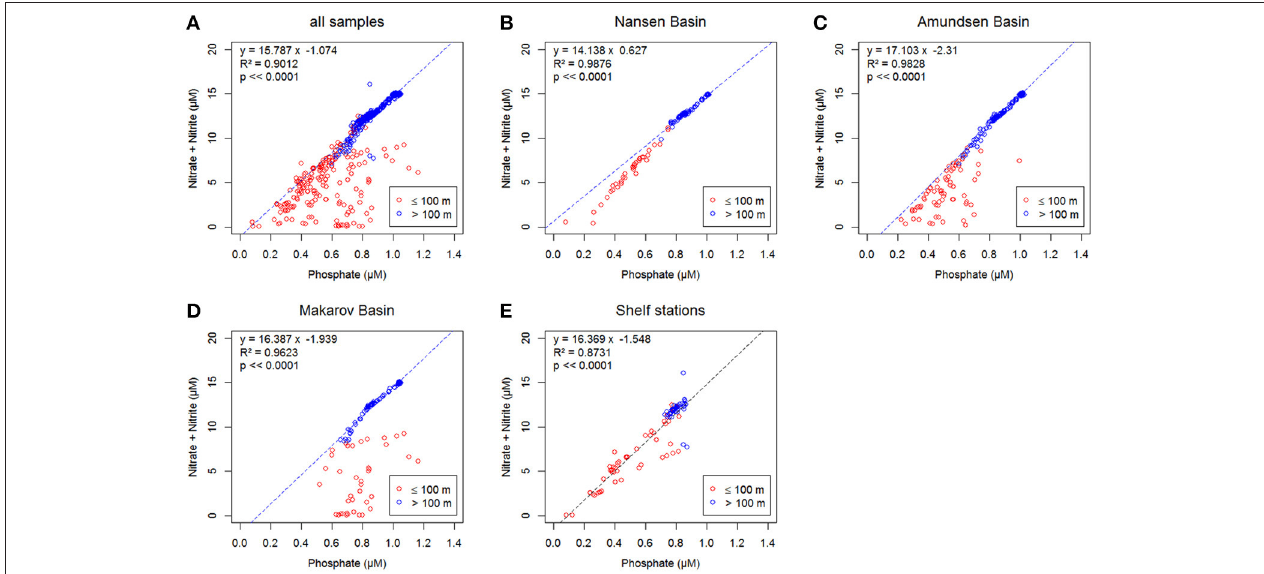
FIGURE 3 | Concentrations of phosphate versus the sum of nitrite and nitrate, in µ M. In blue > 100m, in red ≤ 100m, the equations in A–D show the linear relation for samples > 100m (blue dashed line), the equation in E shows the linear relation for all depths (black dashed line). (A) All samples; (B) Samples taken in the Nansen Basin at stations 32, 40, 50, 54, 58, and 64; (C) Samples taken in the Amundsen Basin at stations 69, 70,81,87, 91, 117, 119, 121, and 125; (D) Samples taken in the Makarov Basin at stations 96, 99, 101, 130, and 134; (E) Samples taken at the shelf at stations 4, 147, 149, 153, 157, 161, 169, and 173 (see Figure 1 for the station locations).